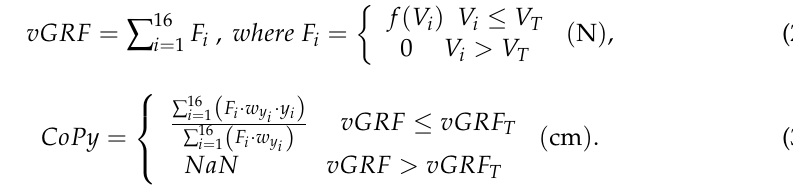
Figure 3. The commercial prosthetic foot, i.e., Pro-Flex XC, and the commercial foot cover (pink) are shown on the left of the picture. On the right, the components of the 3D printed foot cover that enable the prosthetic foot’s accommodation within the cover.